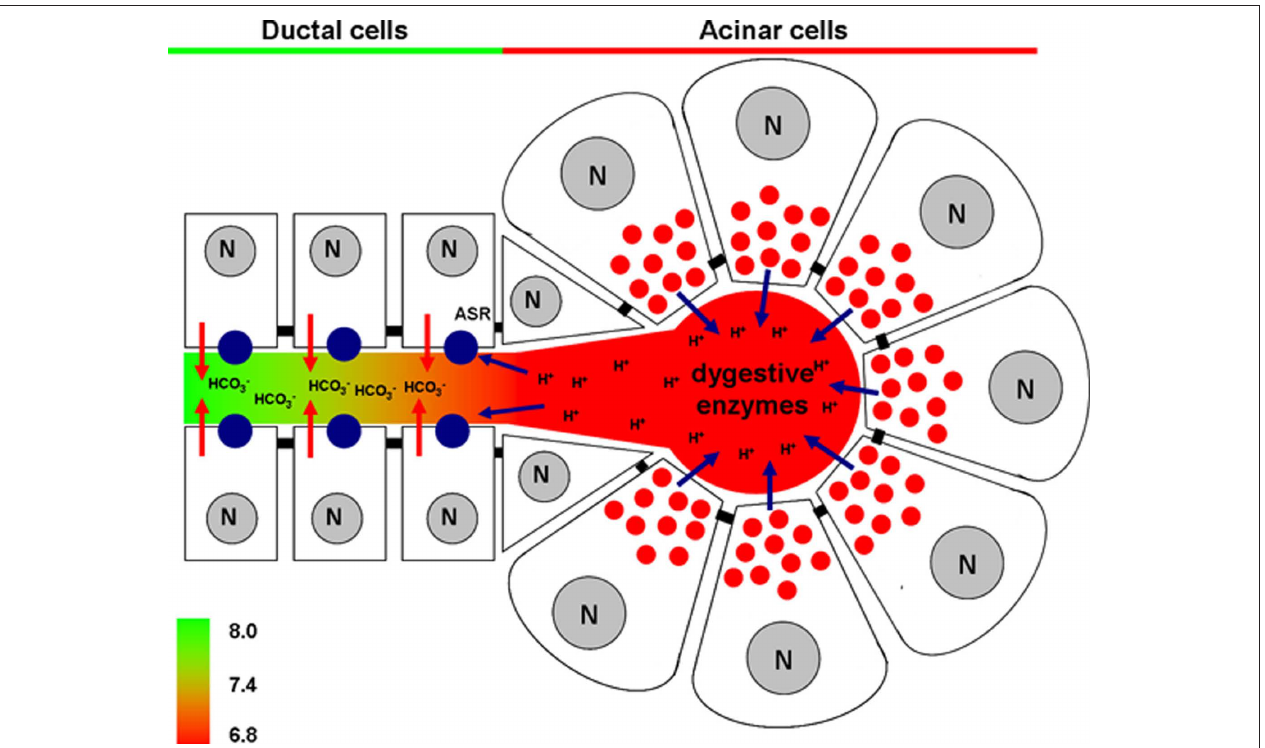
Figure 1 | Changes of luminal pH in the exocrine pancreas during secretion. Under physiological conditions acinar cells secrete digestive enzymes and protons, the latter of which acidify the acinar lumen. In contrast, ductal cells secrete bicarbonate which will elevate the intraluminal pH. Our hypothesis is that protons may stimulate the ductal bicarbonate secretion via acid sensing receptors (ASR), which can elevate the pH in the ductal lumen setting the luminal pH to 8.0.